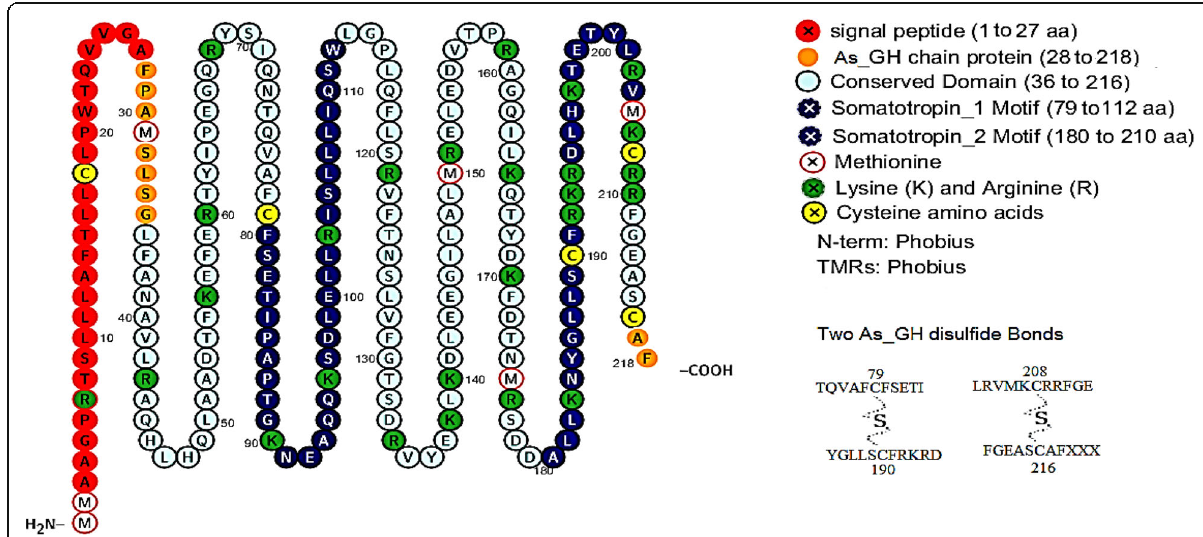
Fig. 16 The Assaf sheep GH_cDNA protein features and disulfide bounds